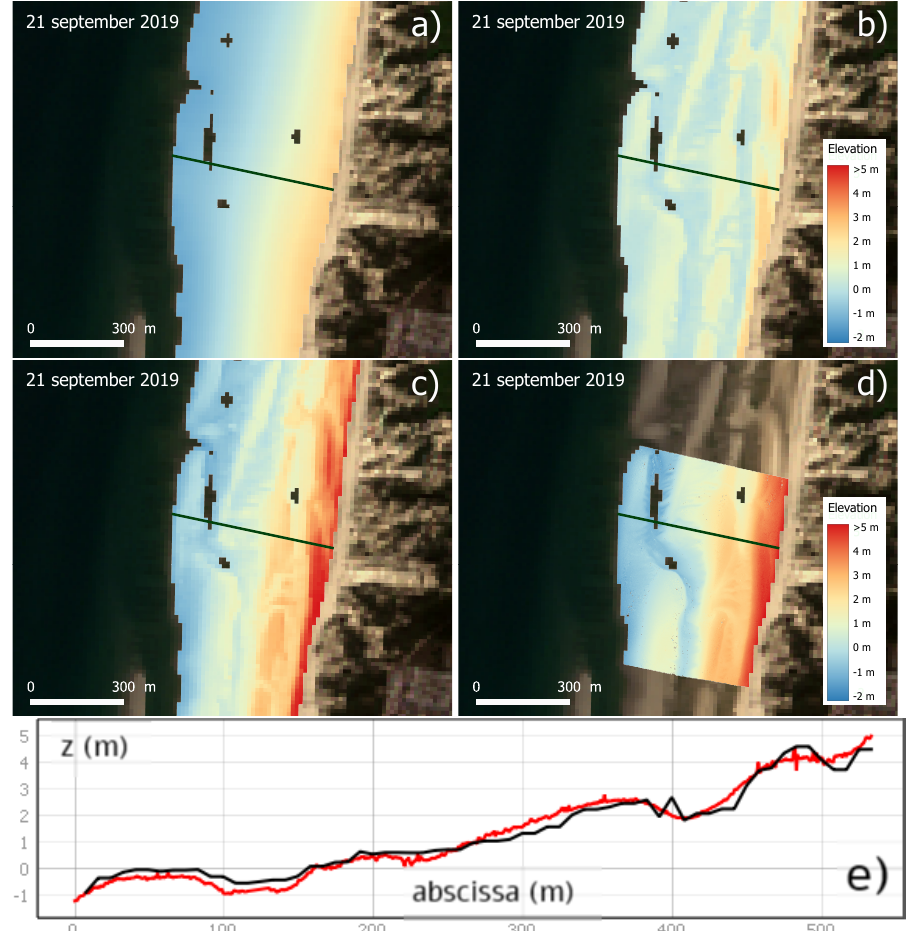
Figure 4. ( a ) Slowly varying signal DEM ( z slow ), superimposed on a Sentinel-2 image of the Berck shoreline site. ( b ) Fast varying signal DEM ( z B 03 ) related to the green band reflectance. ( c ) DEM con- structed from the elevation model z model = z slow + z B 03 . ( d ) Observed data DEM ( z obs ). ( e ) Elevation profiles along the chosen transect according to z model (black), compared to observed data z obs